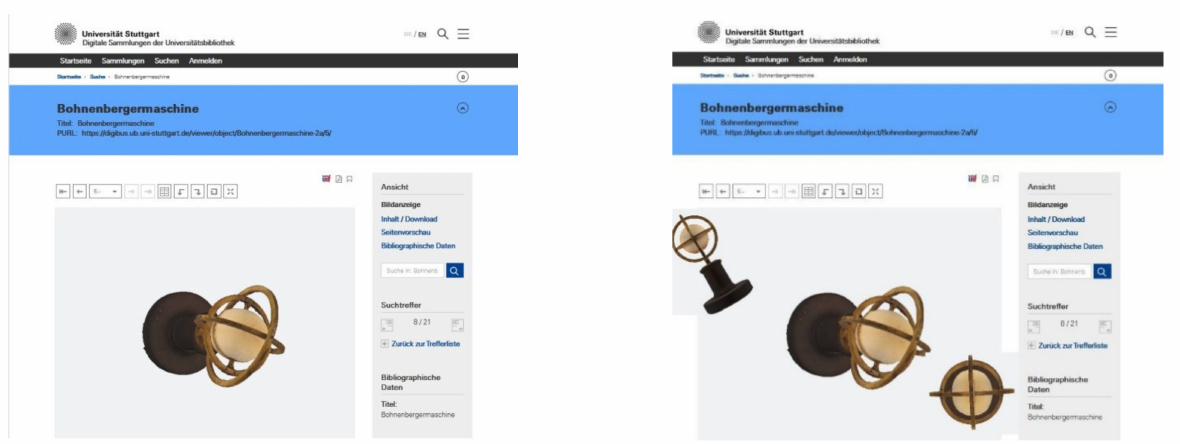
Figure 30. The Machine of Bohnenberger in two successive screen